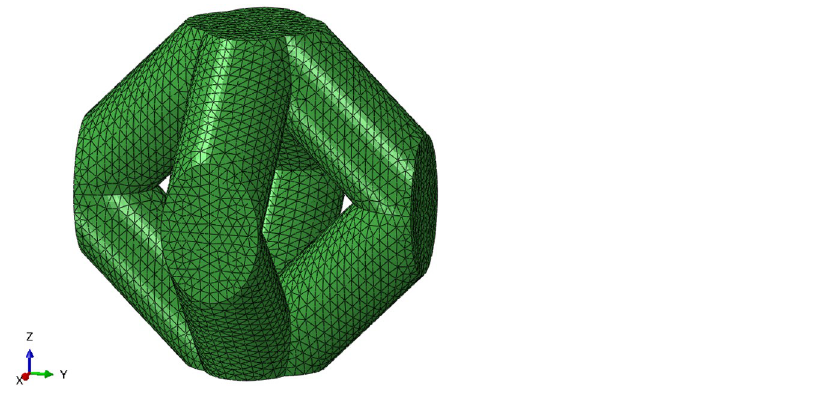
Figure 2. FE model of a unit cell of the RD02